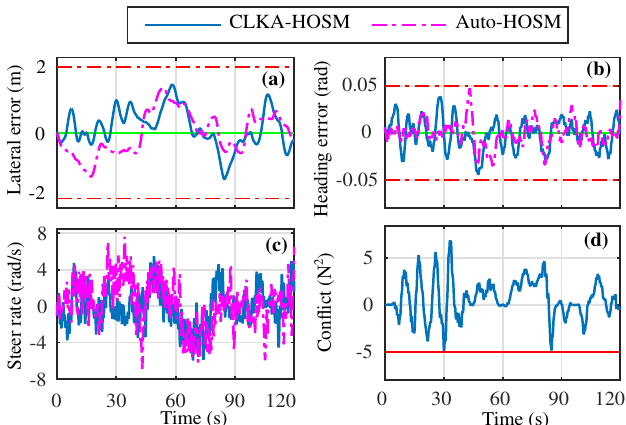
Figure 5. The lane tracking and driver comfort performance for the proposed controller (CLKA- HOSM) and the autonomous controller (Autonomous-HOSM). ( a ) Lateral deviation error; ( b ) Head- ing error; ( c ) steering rate; ( d ) Conflict product of driver and automation torques.